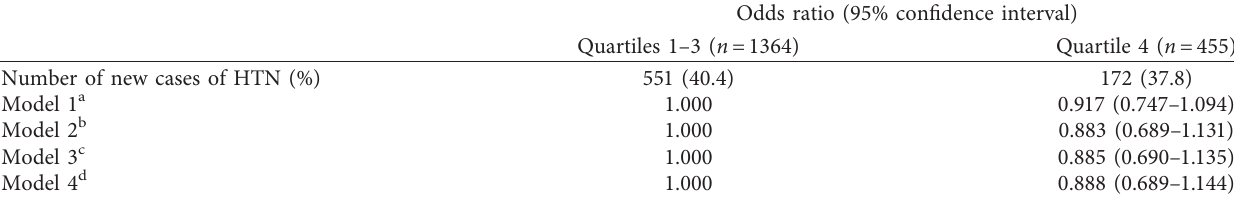
a Adjusted for age and sex; b adjusted for age, sex, and systolic blood pressure at baseline; c adjusted for age, sex, systolic blood pressure, drinking, smoking, and family history of hypertension; d adjusted for age, sex, systolic blood pressure, drinking, smoking, family history of hypertension, body mass index, fasting plasma glucose, total cholesterol, and endothelin-1; HTN, hypertension. Table 5: Odds ratios of risk of hypertension associated with baseline urotensin II levels by strata of endothelin-1 levels.